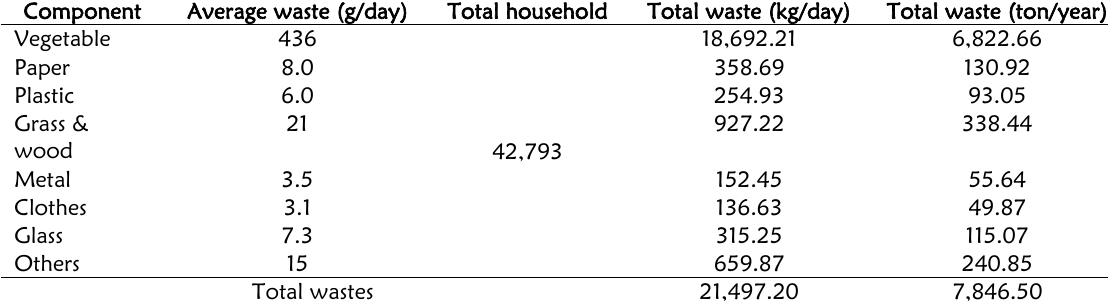
Table 4: Generation of waste in Jessore city [21]